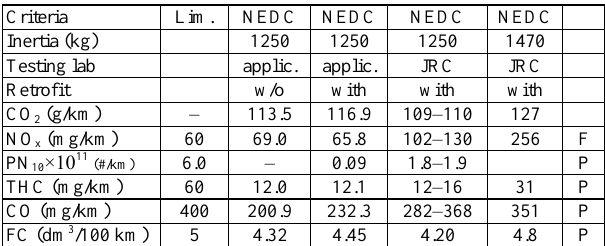
Table 3. Comparison of emissions reported by contestant and measured by JRC using the same setting for cold start NEDC at 25°C. The same cycle with the prize dyno coefficients is also given. F = Fail, P = Pass based on the Engine limits because the prototype vehicle was delivered for the Engine prize (Table 1). Lim.=Limits